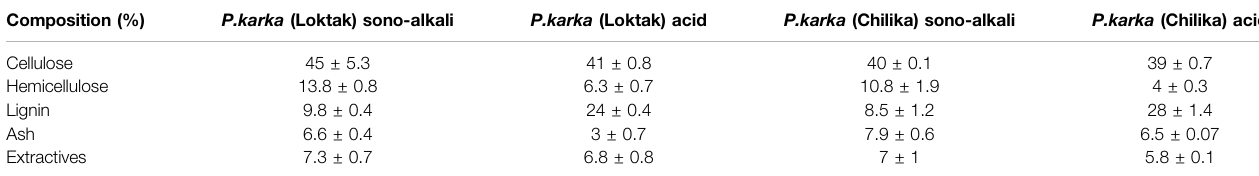
TABLE 2 | Compositional analysis of pretreated Phragmites from Loktak Lake and Chilika Lake. Composition (%)